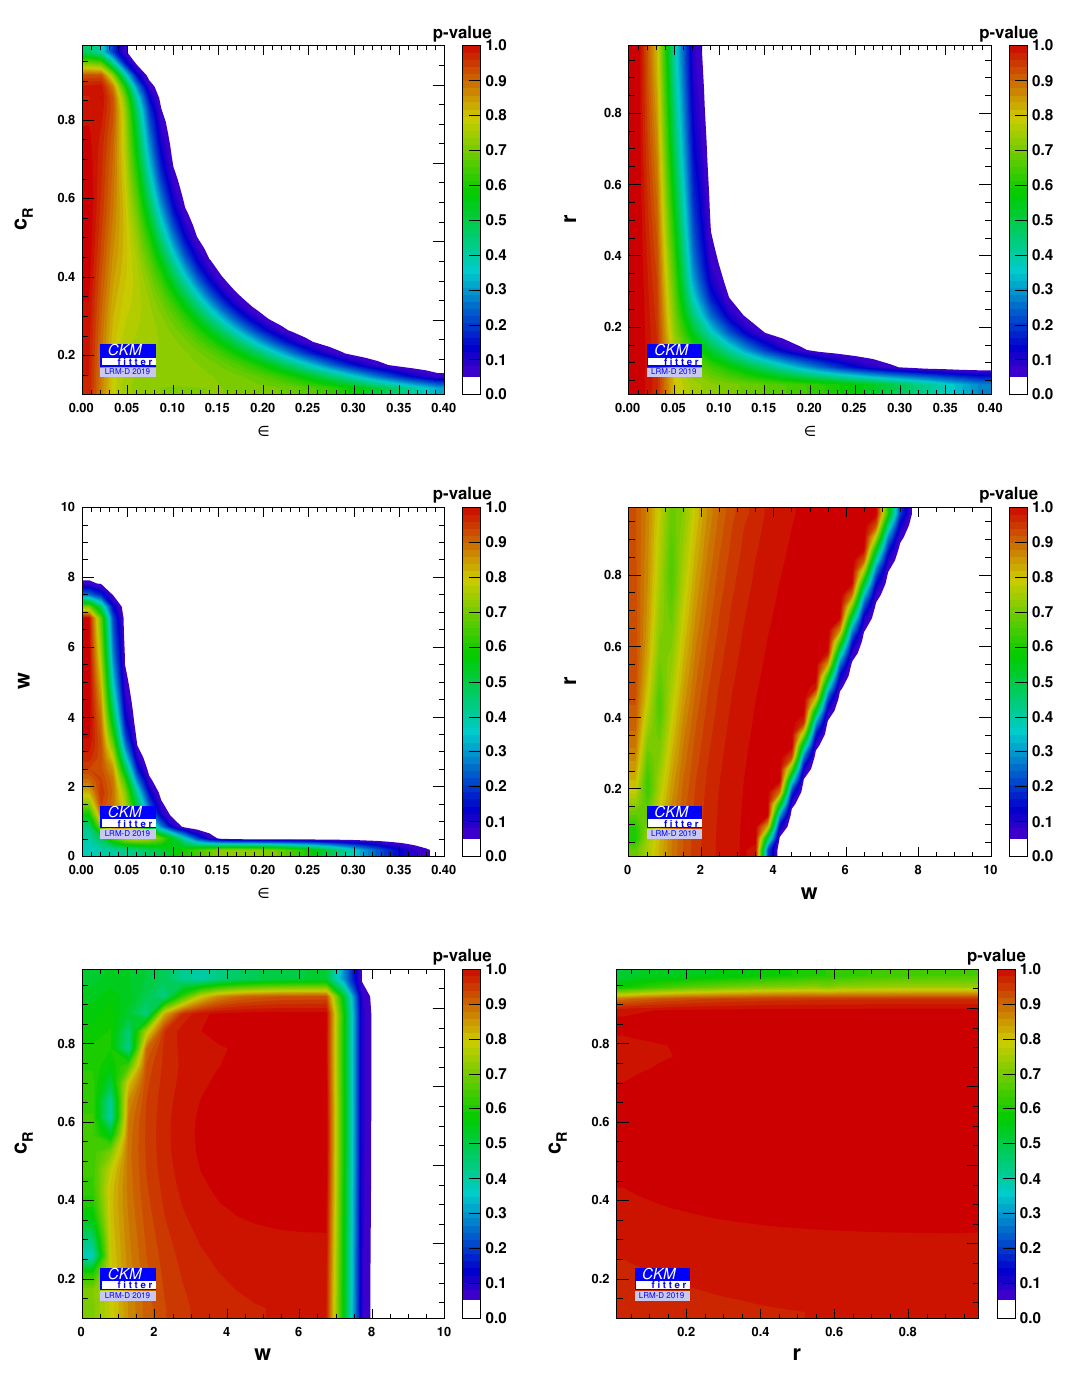
Figure 6 . Correlations between the parameters (cid:15); r; w and c R of the DLRM.